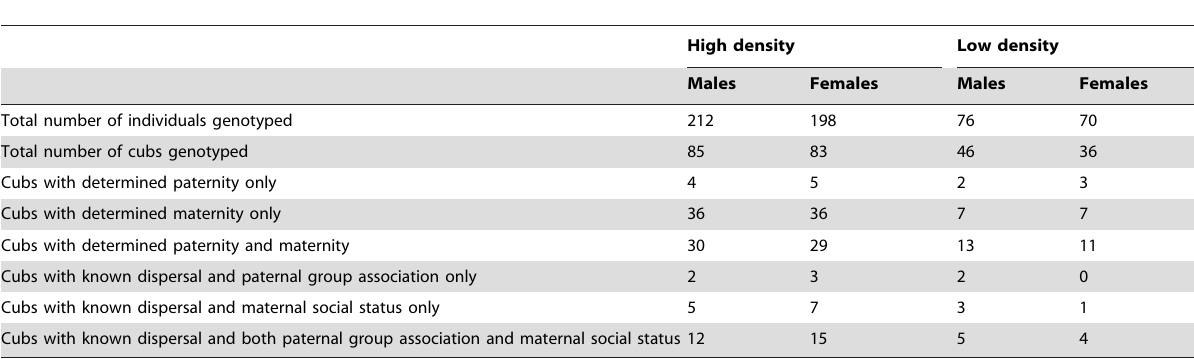
Table 3. Numbers of foxes